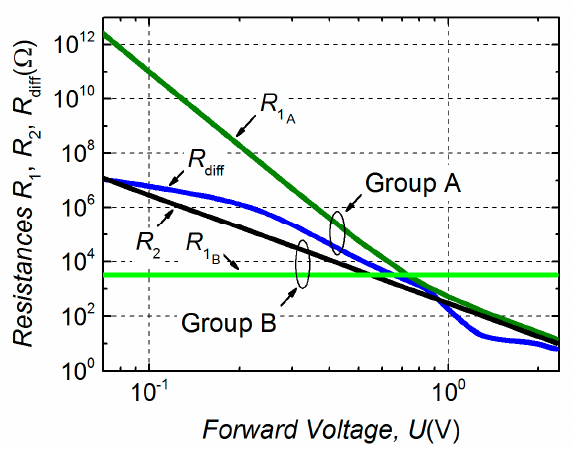
Figure 8. Equivalent electrical circuits of group A ( a ) and group B ( b ) LDs with the voltage noise sources ( R Load >> R mn ).